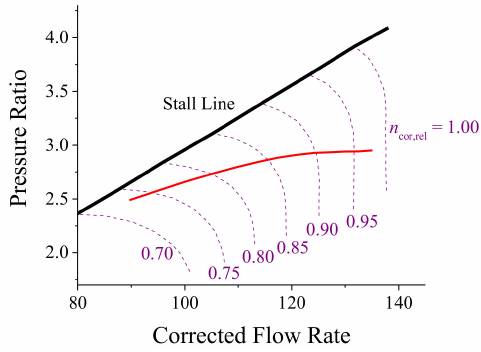
Figure 18. The Matched Operating Line of Front Fan ( bpr 2 = 0.2).